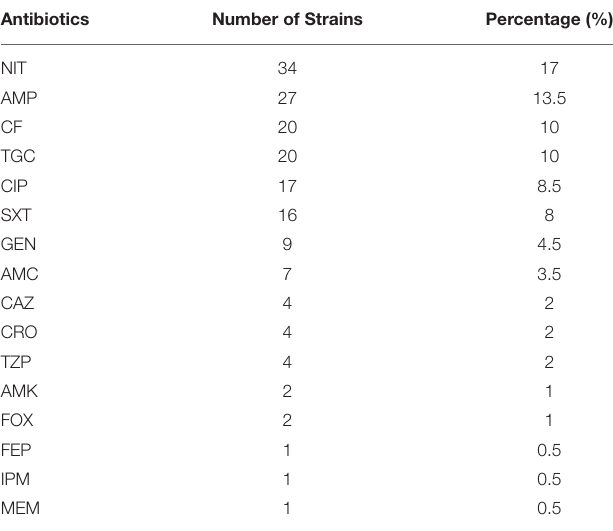
TABLE 5 | Prevalence of antibiotic resistance among human clinical Salmonella